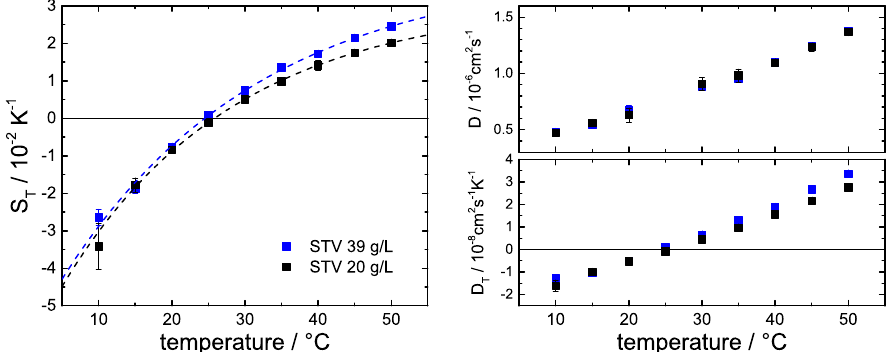
Figure A3. Soret coefficient S T , diffusion coefficient D and thermal diffusion coefficient D T against temperature for streptavidin 39 mg/mL and 20